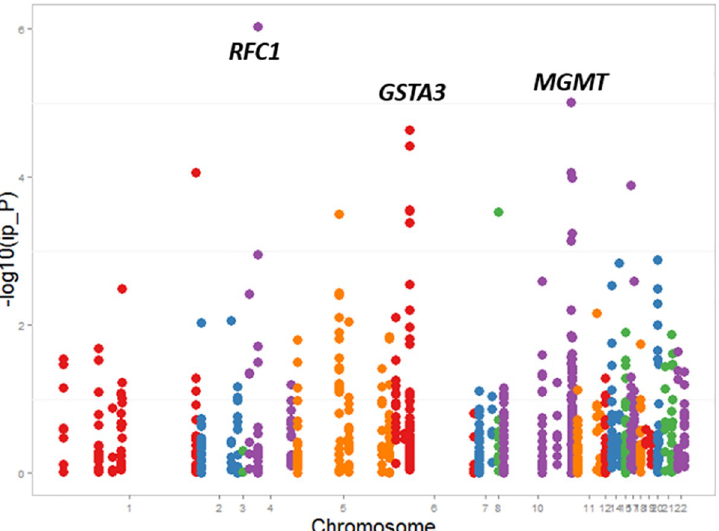
Fig 2. Manhattan plot that shows the location of genes involved in folate, homocysteine, and transsulfuration pathways for which we observed, from hybrid analyses, a significantly decreased risk of obstructive heart defects when the risk variant was paternally-derived compared to maternally-derived, The National Birth Defects Prevention Study, USA, October 1997–August 2008 births.